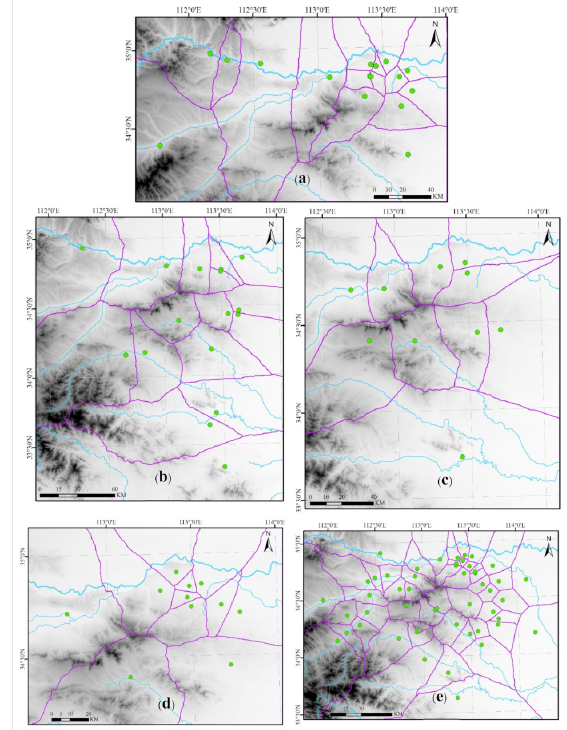
Figure 5. Thiessen analysis for regional early cities. The green dots are the locations of ancient cities at different times. The blue lines are rivers. ( a ) Yangshao periods; ( b ) Longshan periods; ( c ) Erlitou periods; ( d ) Shang dynasty; ( e ) Zhou